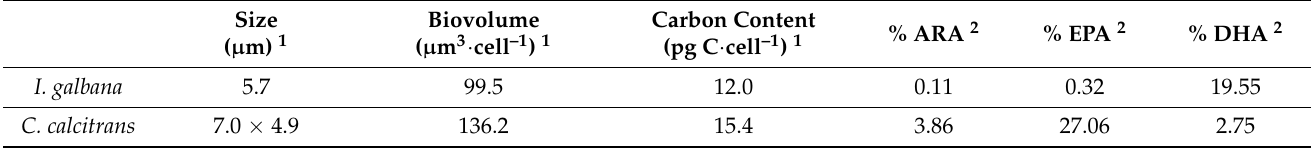
Table 1. Isochrysis galbana and Chaetoceros calcitrans algae general information.